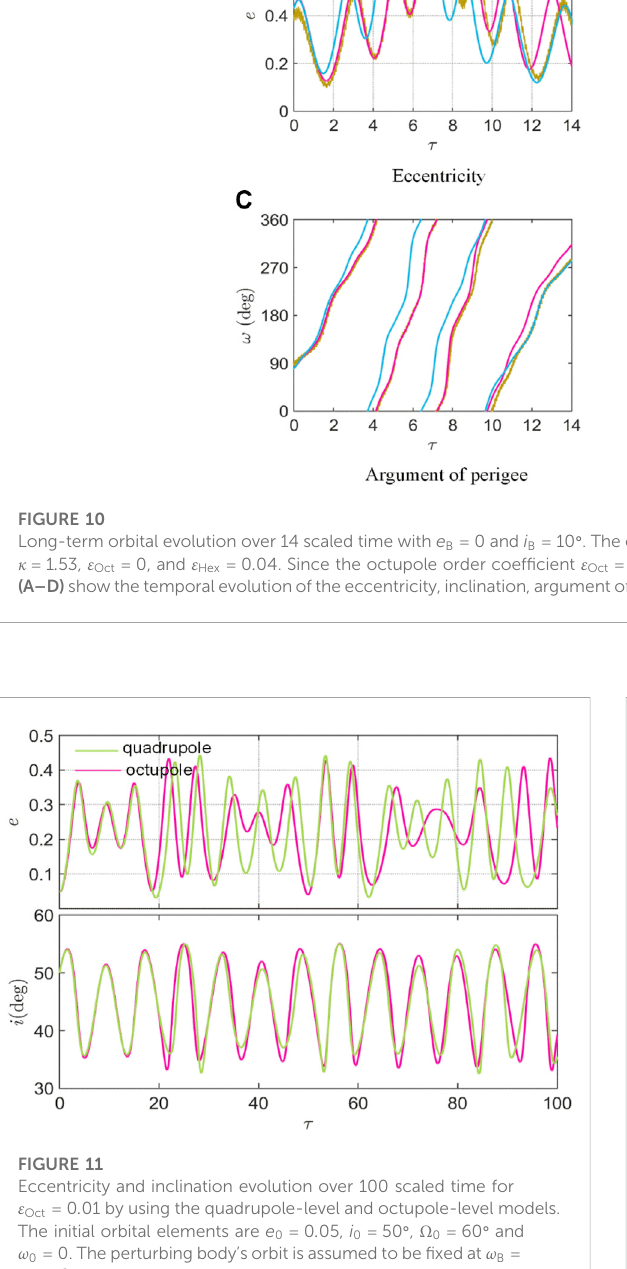
(cid:2) 10 ° in Figure 12 where ε B